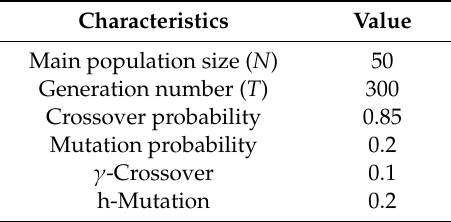
Table 3. Parameters used in SPEA II.